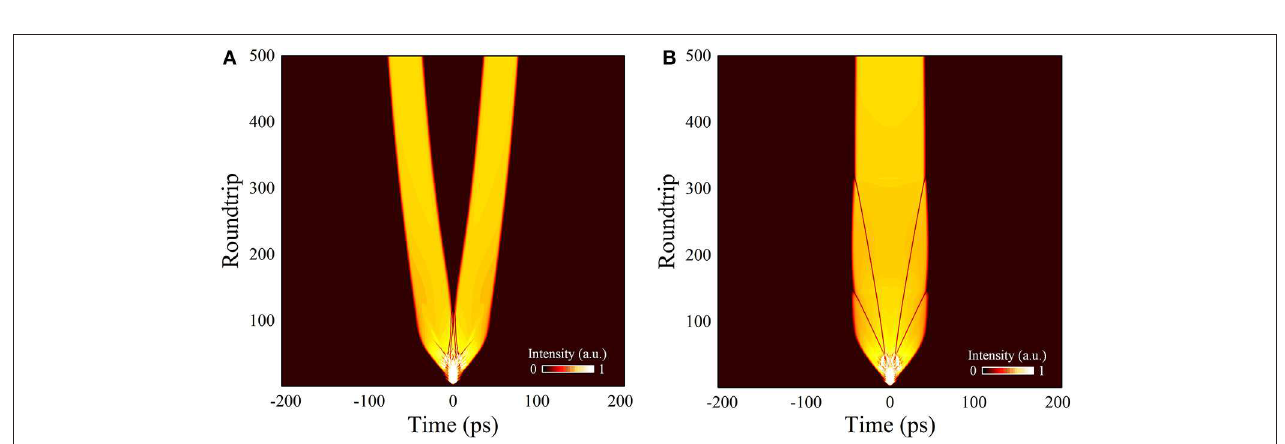
FIGURE 3 | Pulse evolution of first 500 roundtrips at (A) E sat = 2 nJ, (B) E sat = 1.98 nJ.